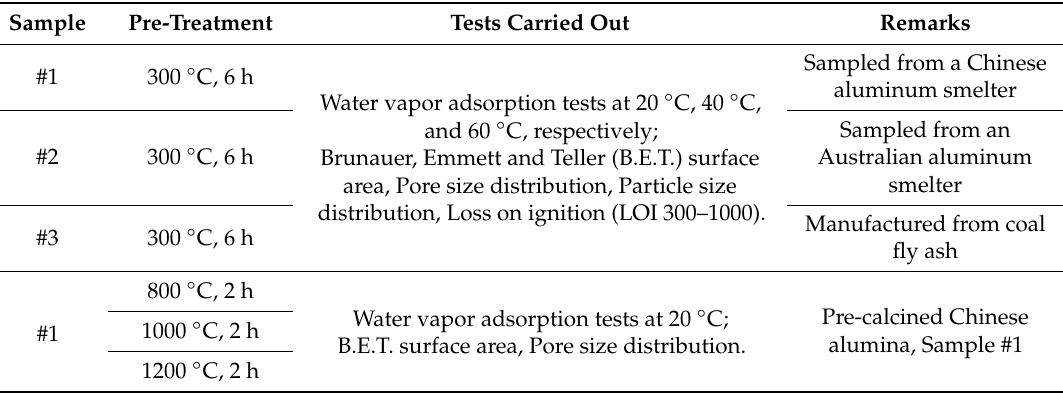
Table 1. Sample treatment and experimental